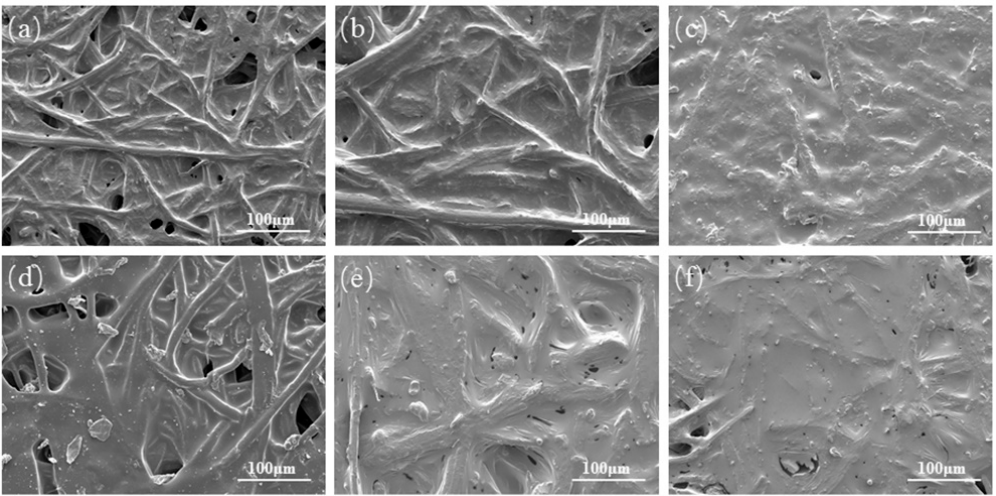
Figure 6. SEM images showing the surface morphologies of ( a ) SEC1.2/30, ( b ) SEC1.2/40, ( c ) SEC1.2/50, ( d ) SEC0.8/40, ( e ) SEC1/40, and ( f ) SEC1.5/40.